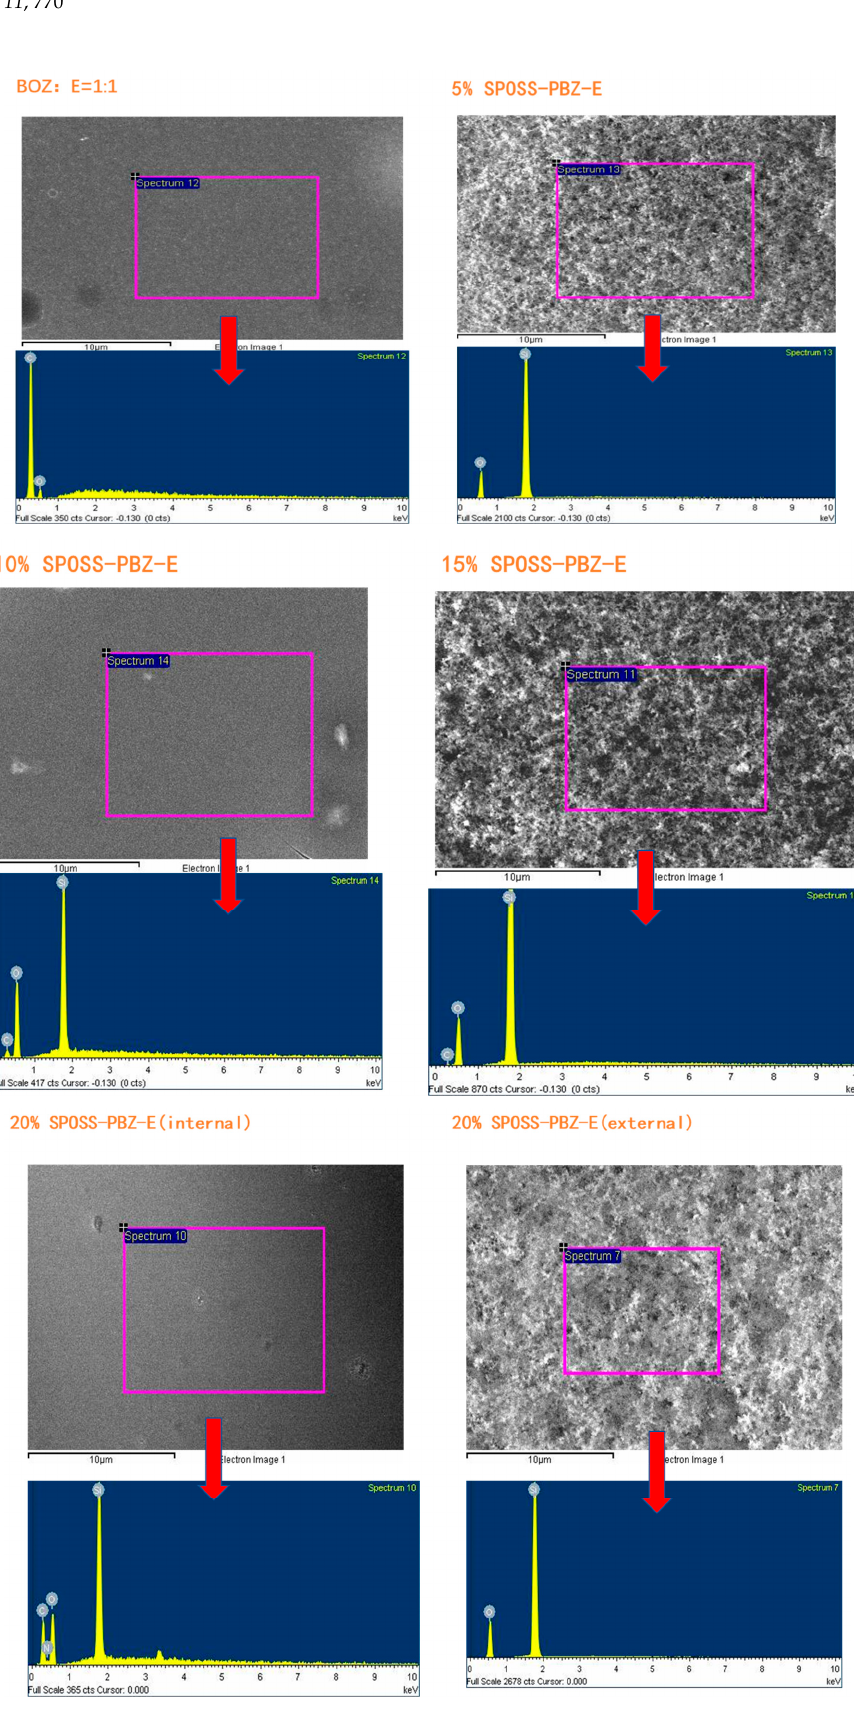
Figure 15. EDX analysis of the char residues remaining after the cone calorimeter test of the SPOSS- BOZ-E